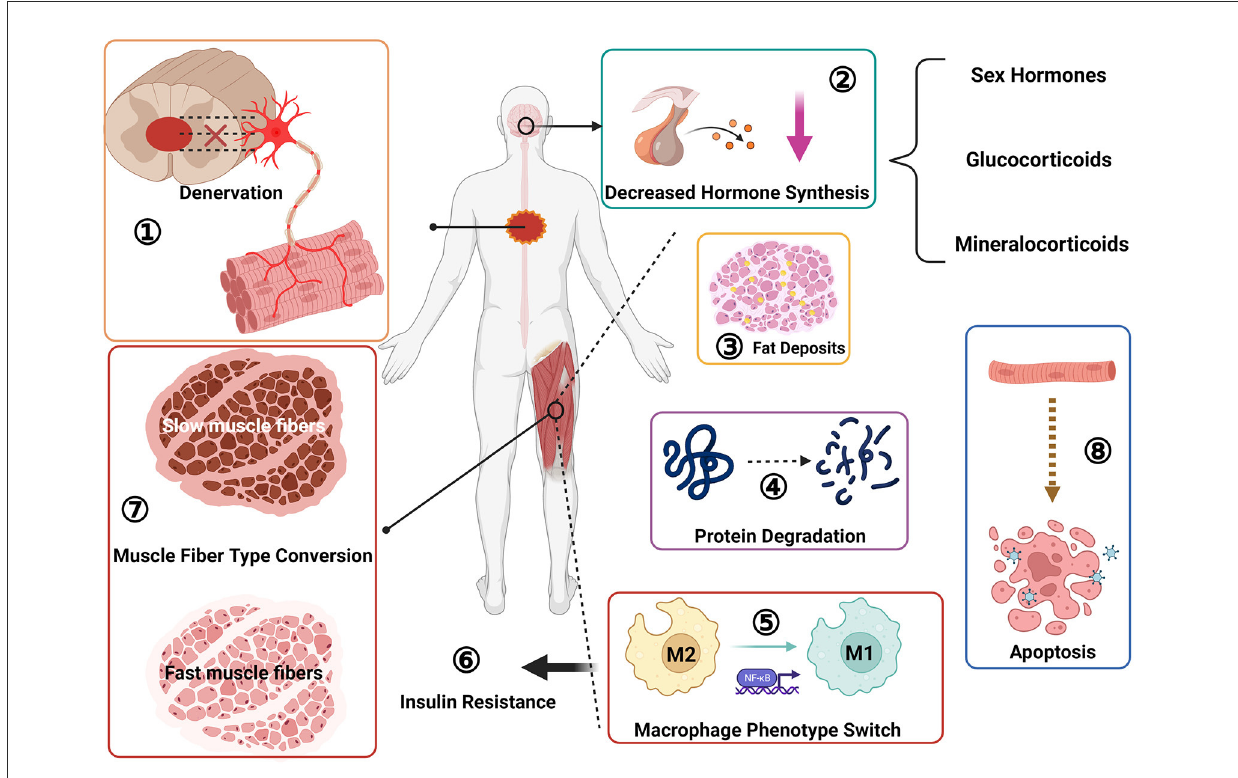
FIGURE2 Pathological changes of skeletal muscle after spinal cord injury: ‹ muscle denervation, neuromuscular junction degeneration; › decreased sex hormone secretion; fi fat deposition; fl protein degradation; (cid:176) macrophage phenotype switch, from M2 to M1 type transition; – insulin resistance; † muscle fiber type transition, from slow oxidation type to fast glycolysis type; ‡ muscle cell